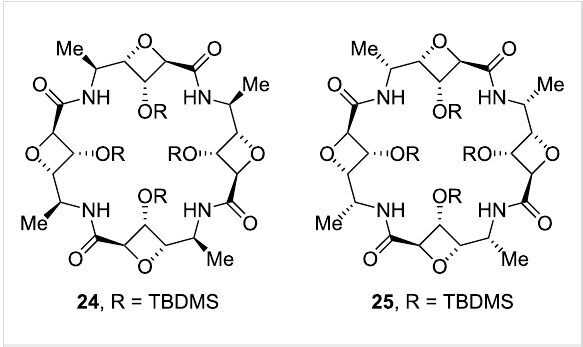
Figure 12: Cyclic tetramers of L- rhamno - and D- gulo -configured oxetane-SAAs.